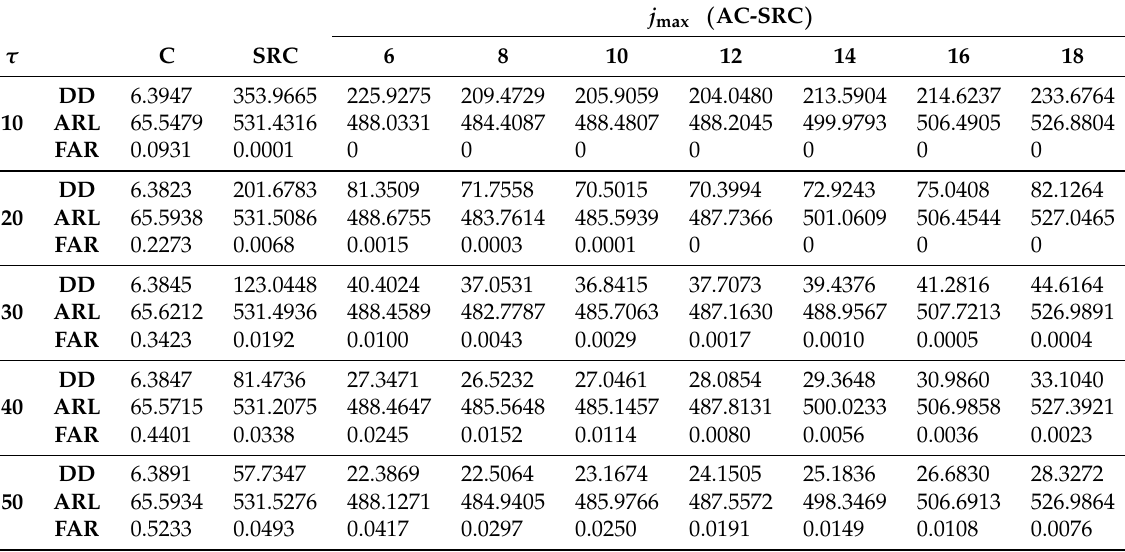
Table 6. ARL 0 = 500, 10% contamination.